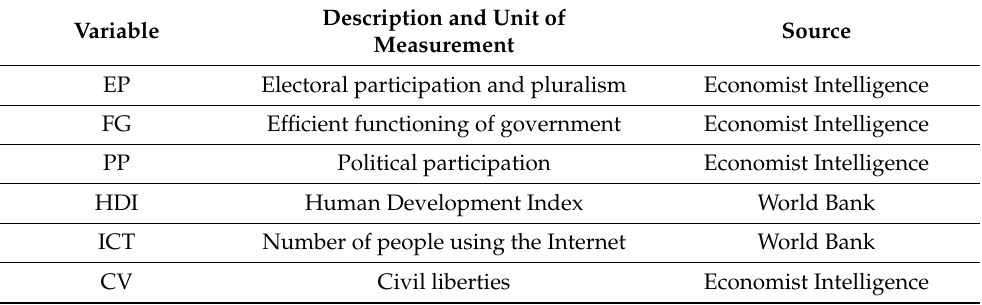
Table 2. Summary of variable